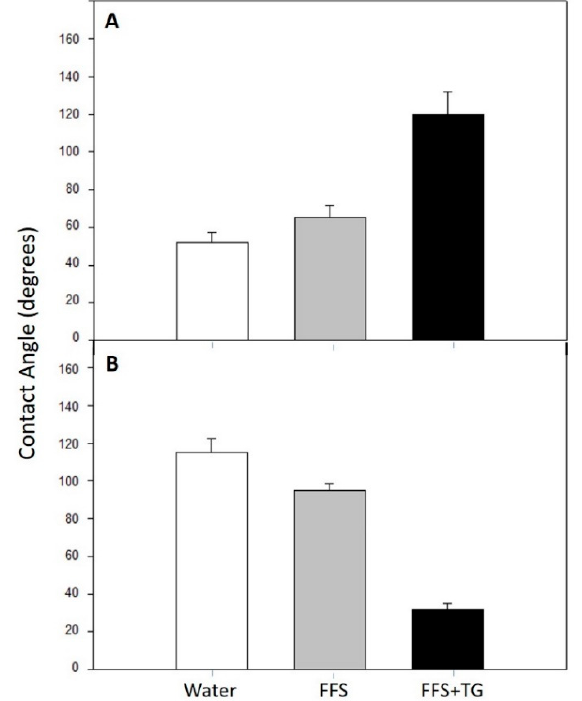
Figure 2. Contact angle of water ( ), FFS ( ) and FFS + TG ( ) on a glass microscope cover slip ( A ) and on a halved, trimmed roasted peanut ( B ). N = 3, values shown are mean ± standard devia- tion.